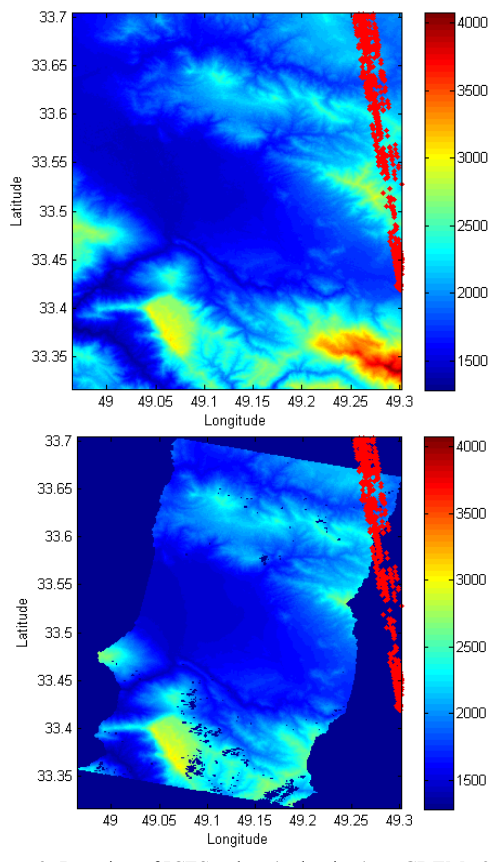
Figure 2: Location of ICESat data (red points) on GDEM v2 (on the top) and TDX (on the bottom)